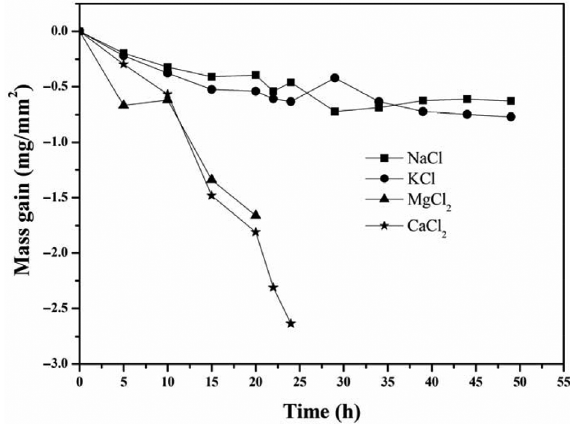
Figure 1: Corrosion kinetics of Inconel 625 in four molten chloride salts at 900°C.